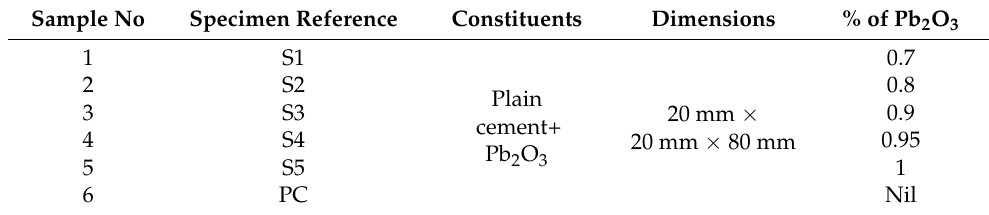
Table 2. Details of the test specimen for mechanical test.